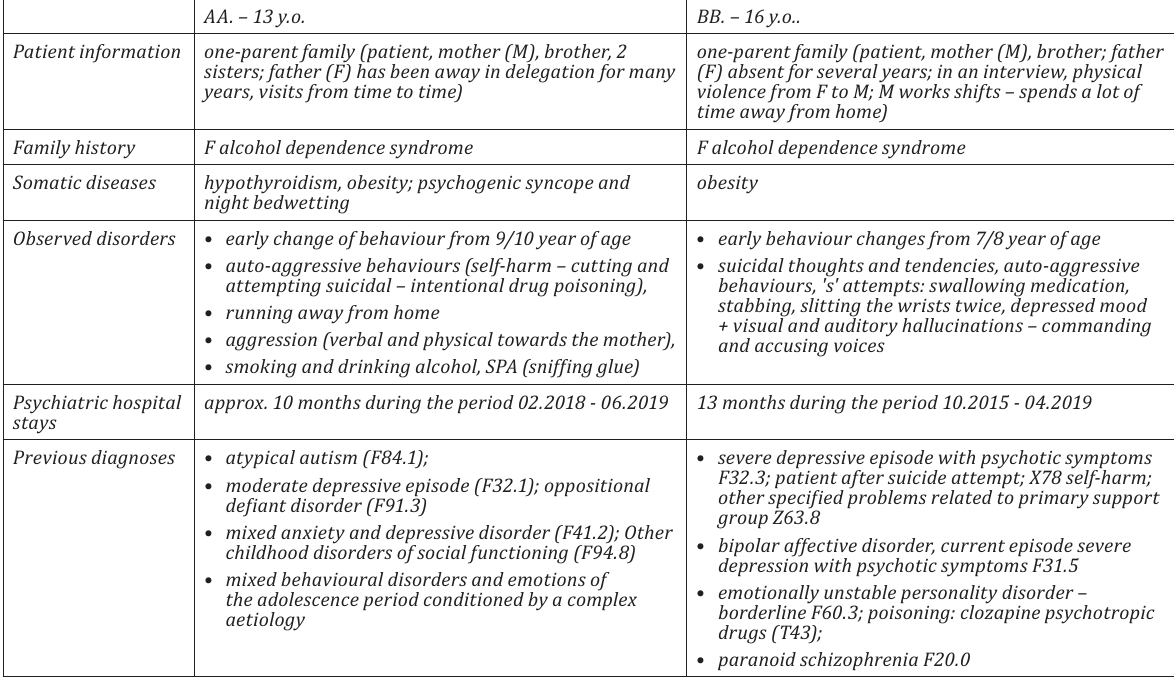
Table 1. Compilation of data on both patients, including the duration of hospitalization and previous diagnoses.